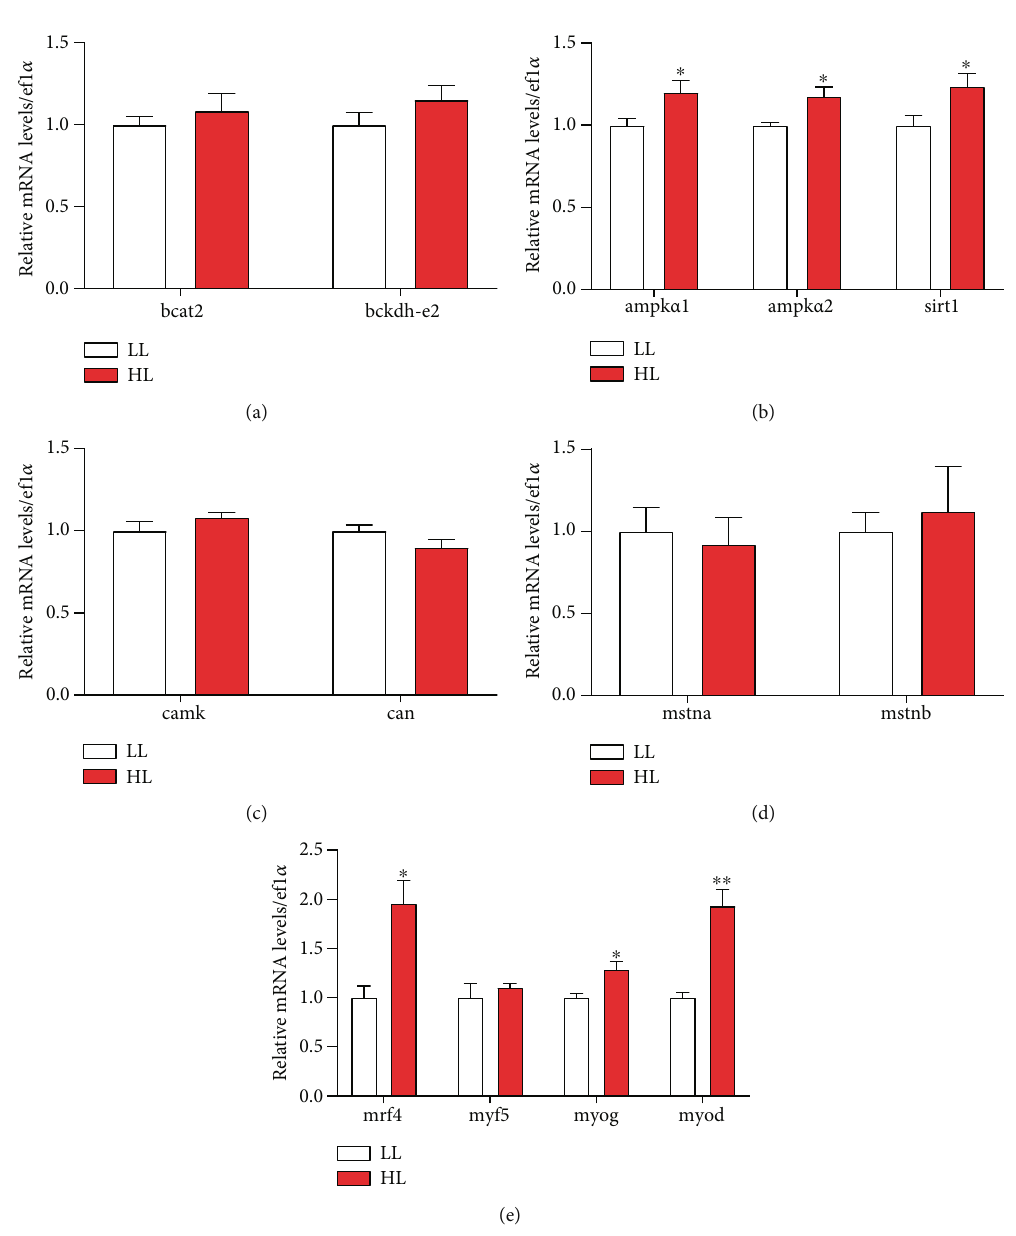
Figure 4: The transcriptional levels of genes involved in energy pathway and muscle fi ber development in white muscle of blunt snout bream. Branched-chain amino transferase 2 ( bcat2 ) (a); branch-chain α -keto acid dehydrogenase E2 ( bckd-e2 ) (a); AMP-activated, protein kinase α 1 ( ampk α 1 ) (b); AMP-activated protein kinase α 2 ( ampk α 2 ) (b); sirtuin 1 ( sirt1 ) (b); Calcium/calmodulin-dependent protein kinase ( camk ) (c); Calcineurin ( can ) (c); Myostatin a ( mstna ) (d); Myostatin b ( mstnb ) (d); myogenin ( myog ) (e); myoblast determination protein ( myod ) (e); myogenic regulatory factor 4 ( mrf4 ) (e); myogenic factor 5 ( myf5 ) (e). Values are represented as mean ± SEM ( n = 4 ) by vertical bars. Values marked with asterisks are signi fi cantly di ff erent (Independent t -test, P < 0 : 05